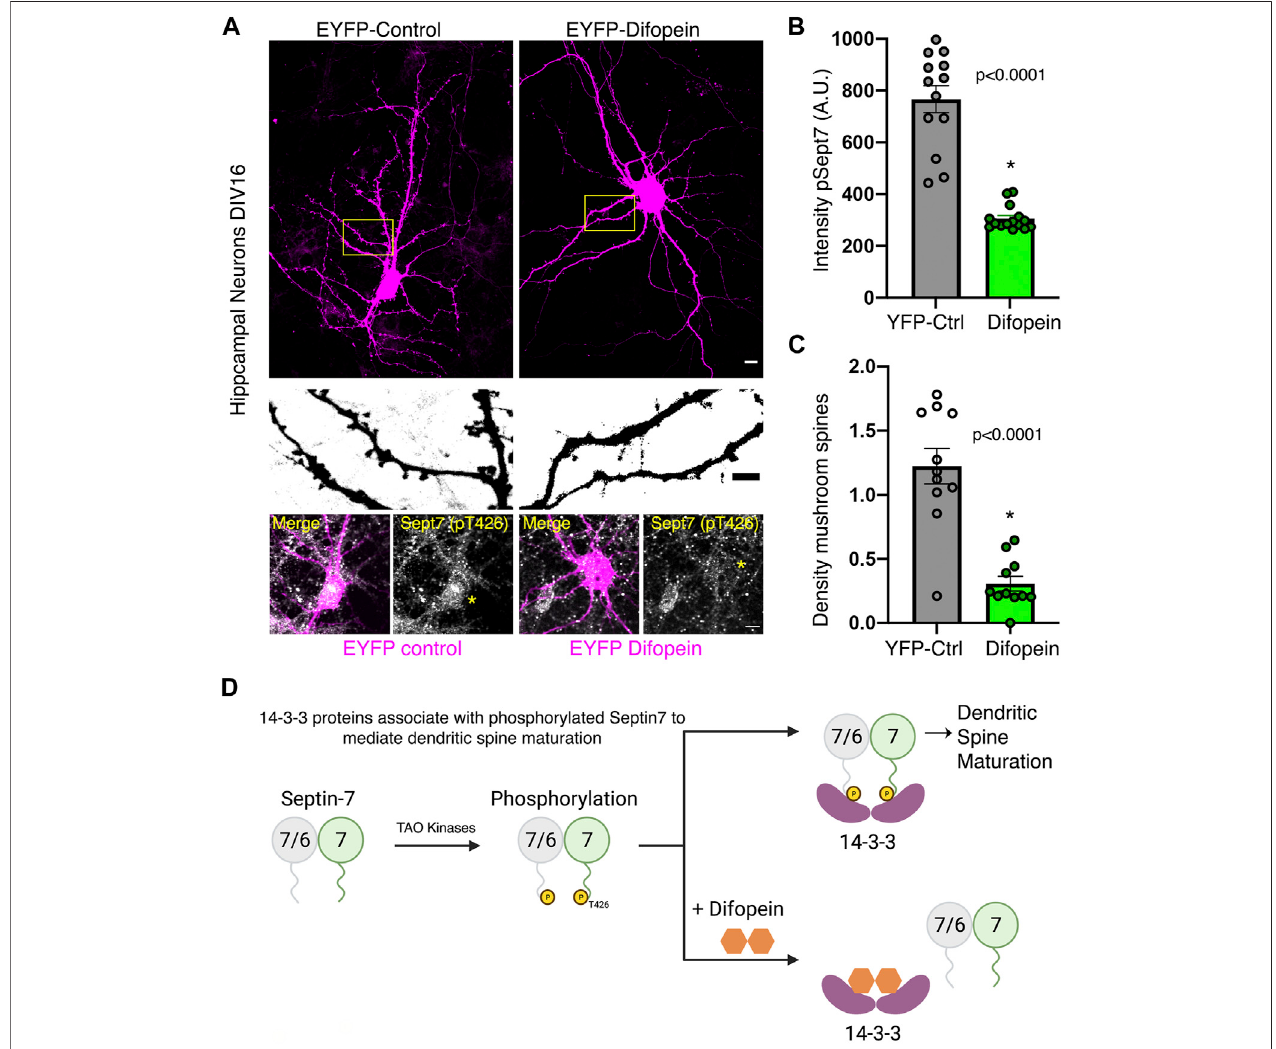
FIGURE 5 | Association with 14-3-3 protects phosphorylation state of Sept7. (A) Fixed images of DIV16 hippocampal neurons transfected at DIV14 with EYFP- controlorEYFP-Difopein(magenta),scalebaris10 μ m.Yellowinsetismagni fi edtohighlightdendriticprotrusionsshownininvertedgrayscale,scalebaris5 μ m.Bottom row shows levels of pSept7 immunostaining (gray) in the neuronal soma of control and difopein-transfected (magenta) neurons. Transfected neurons are depicted by yellow asterisk, and scale bar is 5 μ m. (B) Quanti fi cation of phosphorylated Sept7 levels in the soma of DIV16 hippocampal neurons expressing YFP-control or YFP-Difopein. YFP-Difopein expression results in signi fi cantly decreased levels of phosphorylated Sept7 ( p < 0.0001). Values indicate mean; error bars represent SEM; and n = 13 and 15 neurons, respectively, from three distinct experiments. (C) Density of mushroom spiny protrusions in DIV16 hippocampal neurons expressing YFP- control or YFP-Difopein. Values indicate mean, error bars represent SEM, and n = 11neurons each from three distinct experiments. (D) Schematic summarizes fi ndings of this study showing 14-3-3 protein association modulates Sept7 function in neurons through protection of its phosphorylation state.